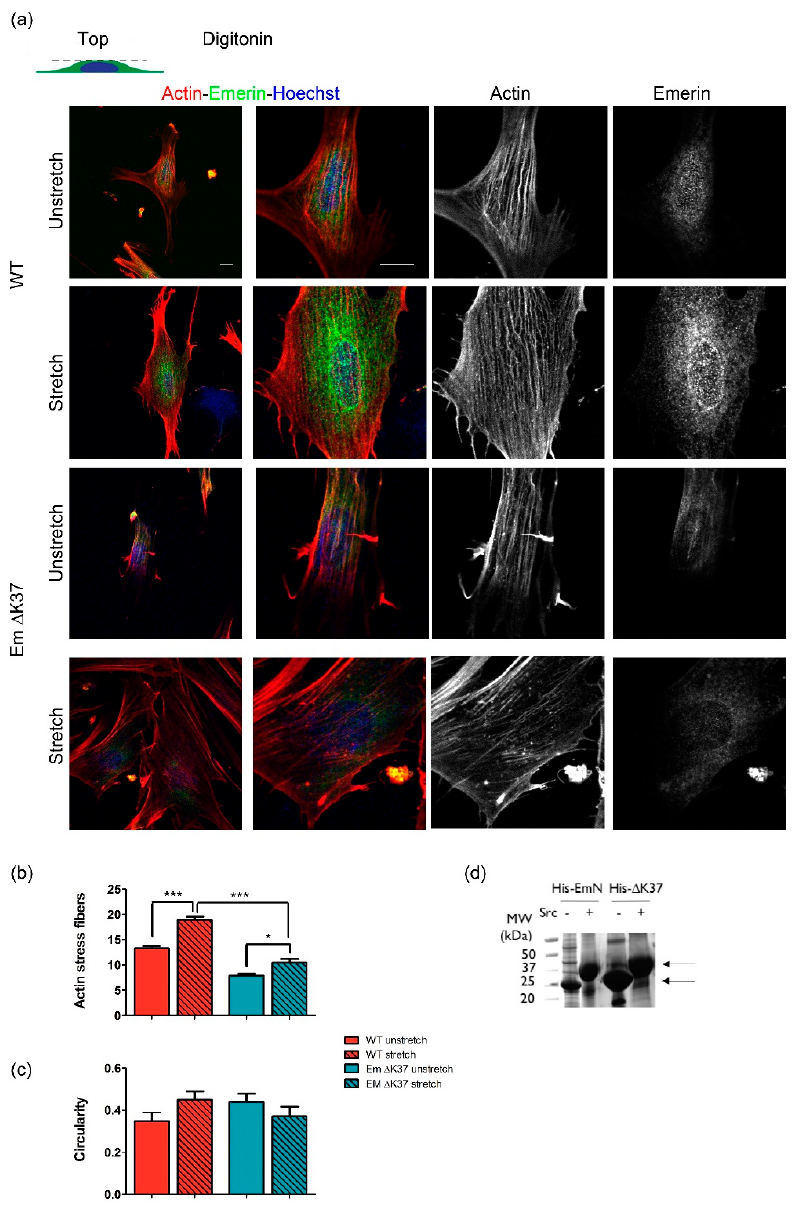
Figure 6. Mutation ∆ K37 impairs the perinuclear actin response to cyclic stretch. ( a ) Representative images of wild-type (upper panels) and Δ K37 (lower panels) myofibroblasts stained for F-actin (phalloidin, red), emerin (green) and nuclei (Hoechst, blue) in unstretched and stretched conditions. The outer nuclear membrane was permeabilized using digitonin and cells were subjected to 10% cyclic stretch at 0.5 Hz for 4 h. Scale bar, 10 µm. ( b ) Number of actin stress fibers in wild-type (red) and Δ K37 (blue) myofibroblasts in unstretched (clear) and stretched (striated) conditions. Data represent mean ± SEM from 30 ± 1 cells for each condition in two independent experiments. * p <0.05, *** p <0.001 versus WT. ( c ) Contour ratio (4 π area/perimeter 2 ) as a measurement of nuclear circularity, calculated for wild-type (red) and Δ K37 (blue) myofibroblasts in unstretched (clear) and stretched (striated) conditions. Data represent mean ± SEM in 30 ± 1 cells for each condition in two independent experiments. ( d ) Phosphorylation of 8His-EmN and 8His- Δ K37 (0.9 mg) by Src kinase (0.9 µg) in 2 mM ATP, 0.5 mM MgCl 2 , 5 mM DTT, 20 mM Tris HCl pH 7.5, protease inhibitor, overnight at 30 ◦ C. The SDS-PAGE gel shows 8His-EmN and 8His- ∆ K37 before ( − ), and after phosphorylation ( + ). Two arrows indicate where EmN migrates before and after